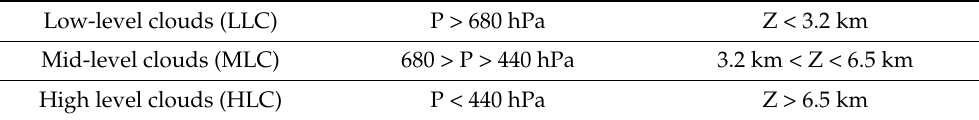
Table A3. Summary of the calculated statistics for the models and satellite-based data used in this study. The annually averaged global mean cloud fraction (CF), model bias (mean difference =